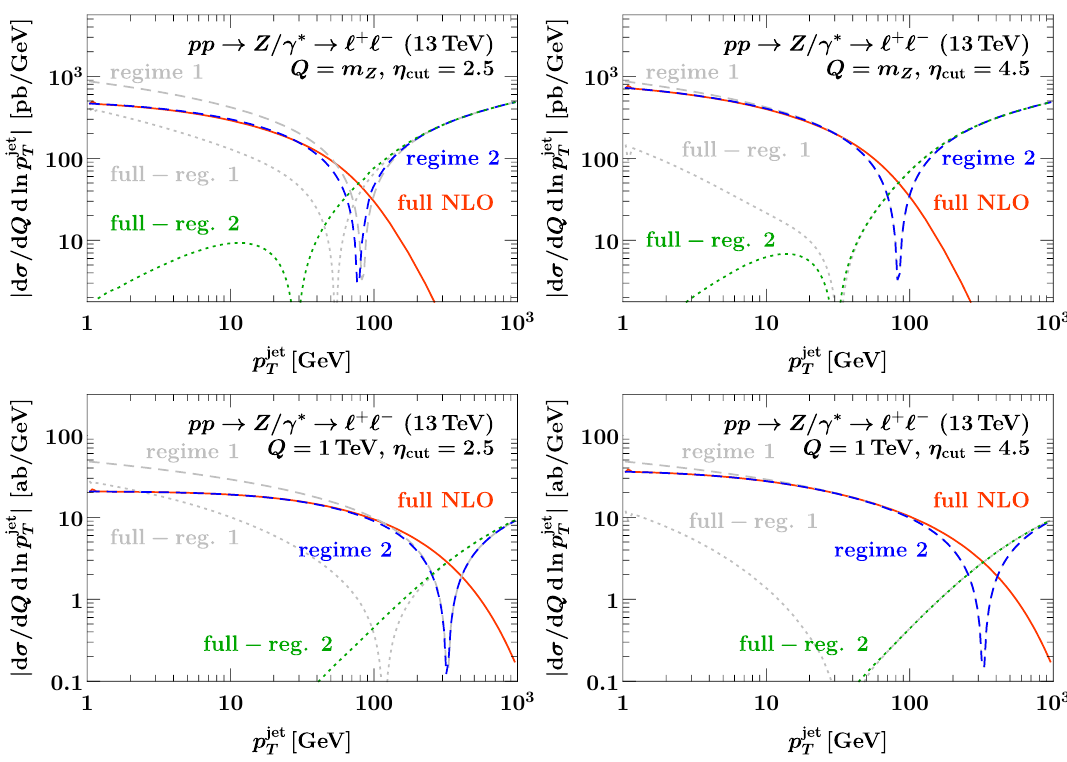
Figure 5 . Comparison of singular and nonsingular contributions to the (cid:12)xed spectrum with rapidity cut (cid:17) jet < (cid:17) cut for Drell-Yan at Q = m Z (top row) and Q = 1 TeV (bottom j j row), (cid:17) cut = 2 : 5 (left) and (cid:17) cut = 4 : 5 (right). The meaning of the curves are as in (cid:12)gure